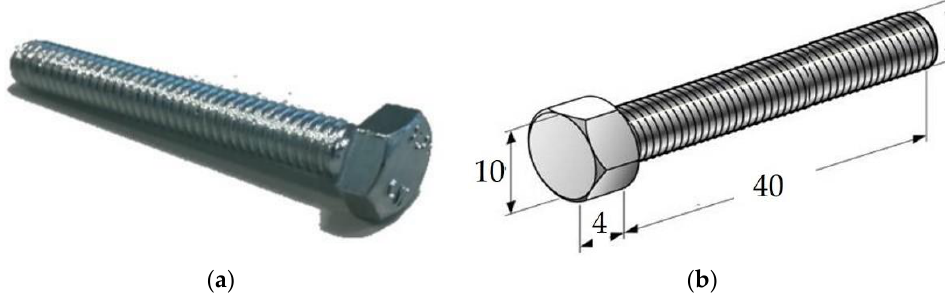
Figure 4. ( a ) Photo of the M6 × 40 steel bolt; ( b ) sketch and dimensions of the utilized steel bolt (dimensions are in mm).